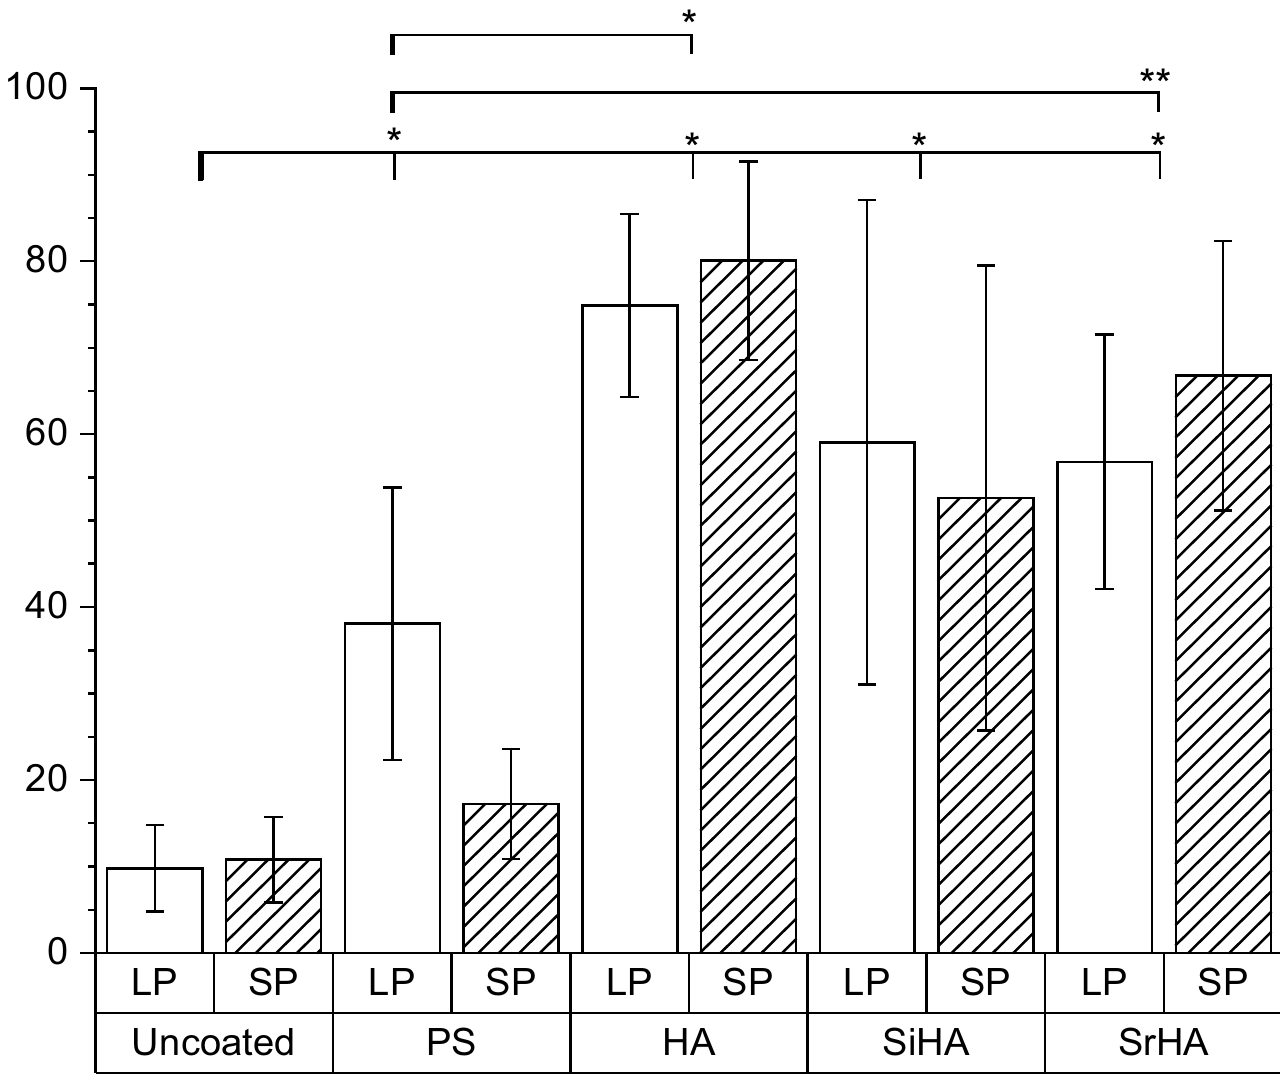
Fig 6. Extent of osseointegration measured by bone implant contact. Boxes indicate mean and lines standard deviations. PS, plasma sprayed HA; HA, electrochemical HA; SiHA, electrochemical SiHA; SrHA, electrochemical SrHA; SP, 700 μ m implant; LP, 1500 μ m implant. � p < 0.001, �� p < 0.02.